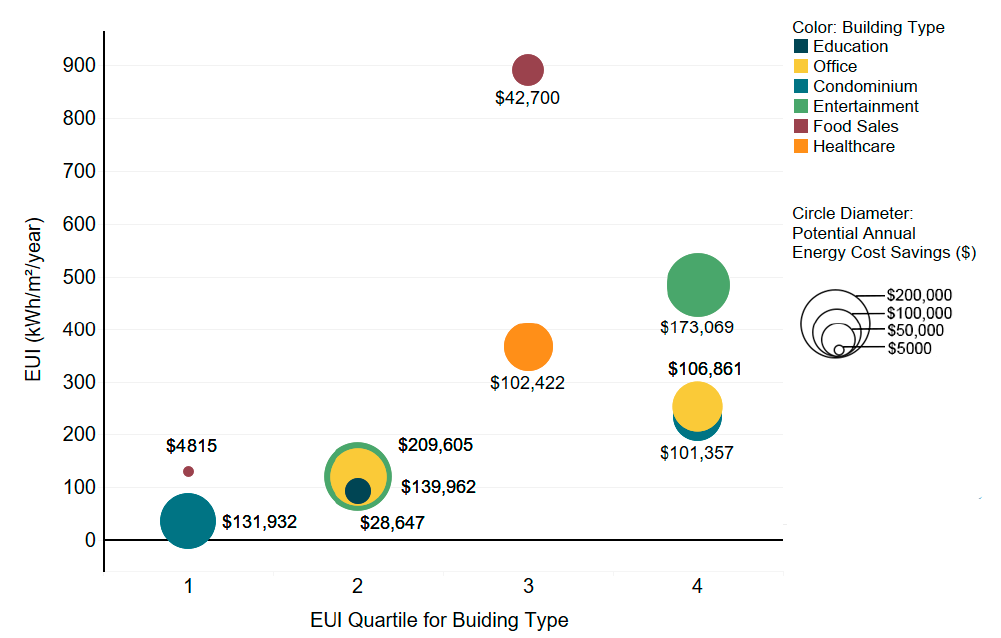
Figure 4. Energy use intensity (EUI; kWh/m 2 /year) of each building vs. the quartile it ranks within, compared with peer buildings. Estimated potential annual energy cost savings indicated by size of bubble, and building type indicated by color.